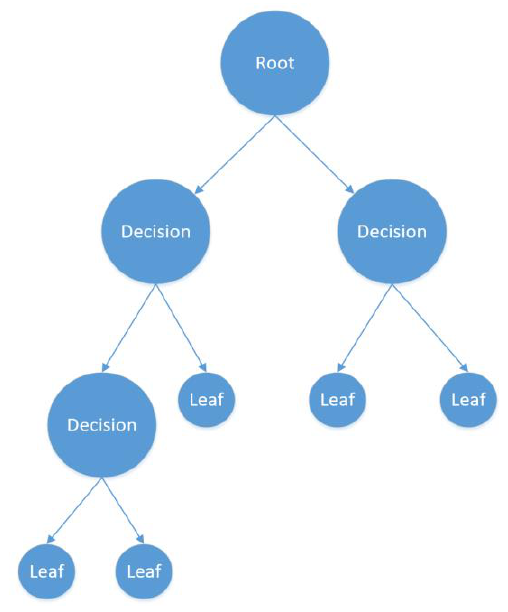
Figure 4. Decision Trees. Figure 4. Decision